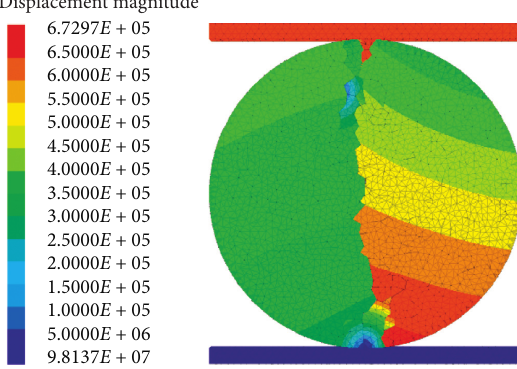
Figure 5: Loading displacement cloud of homogeneous model.